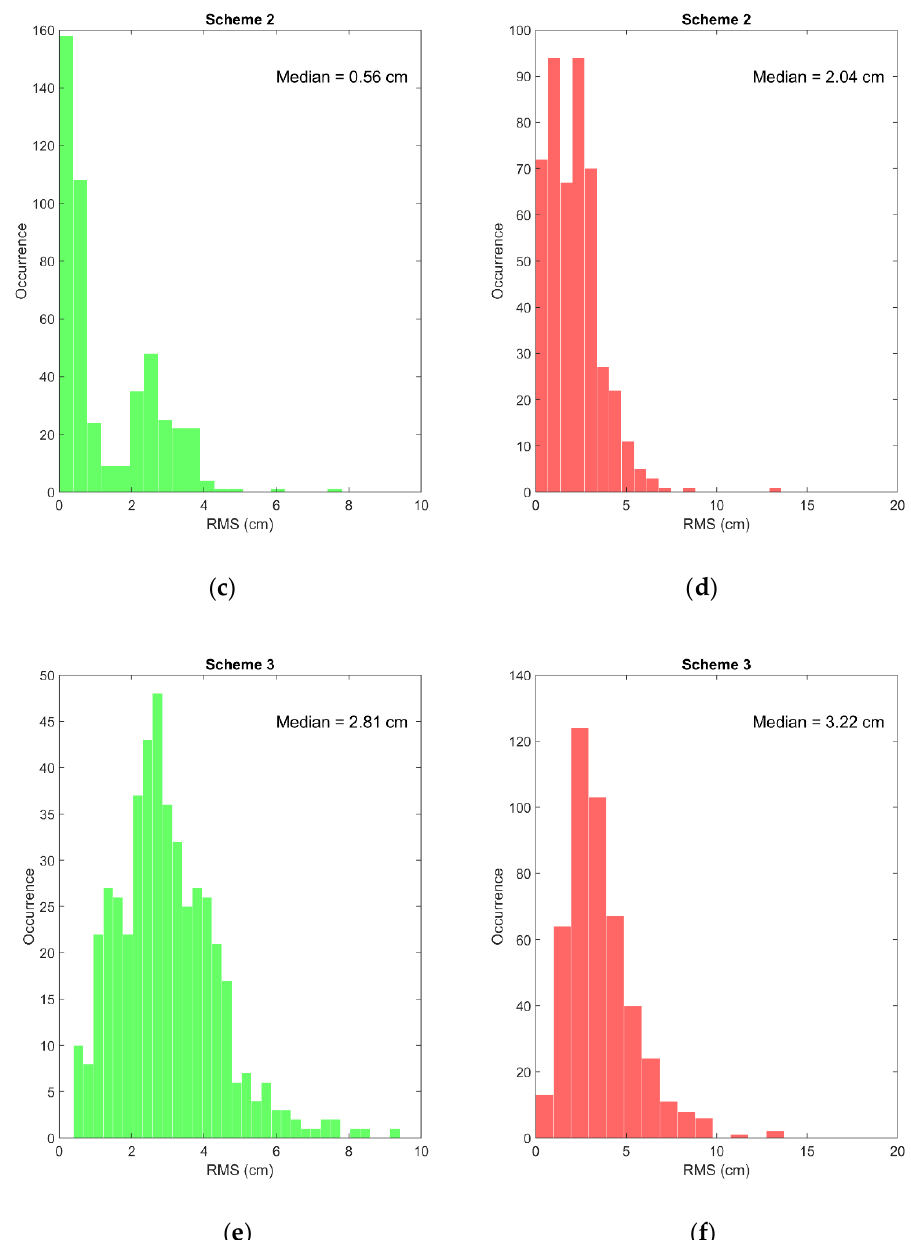
Figure 4. Distribution of the RMS positioning errors obtained with the proposed dual-frequency PPP-RTK model for the horizontal ( a , c , e ) and vertical ( b , d , f ) components for the three different processing schemes: Scheme 1 ( a , b ), Scheme 2 ( c , d ), and Scheme 3 ( e , f ).